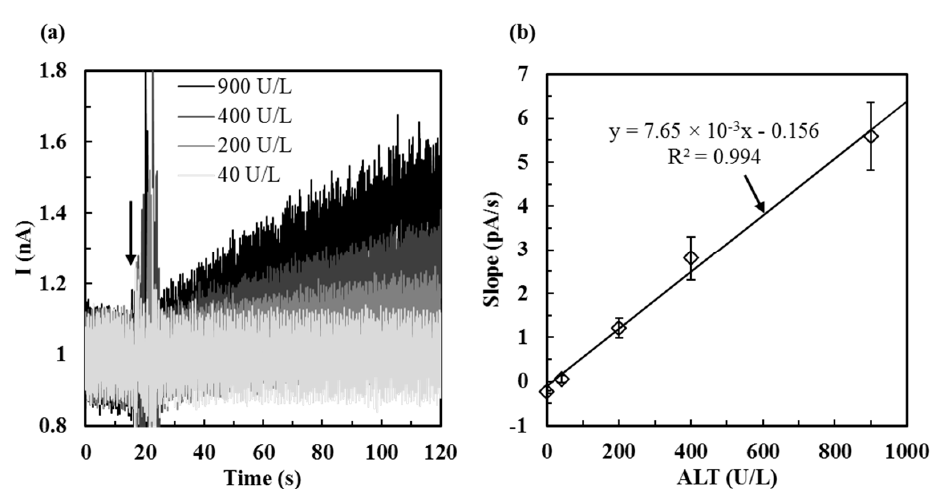
Figure 5. ( a ) ALT current responses corresponding to ALT activities (from 40 U/L, 200 U/L, 400 U/L, to 900 U/L) tested by Method 1 after one day of storage at − 20 °C. The arrows indicate the timing of ALT addition; ( b ) The calibration curve of ALT biosensors ( N = 10) tested by Method 1 .